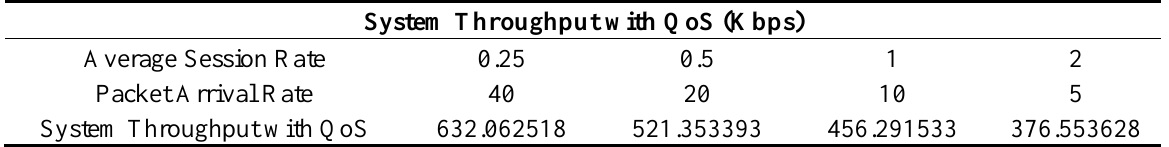
Table 9. Evaluation with different session rates (system throughput with QoS).